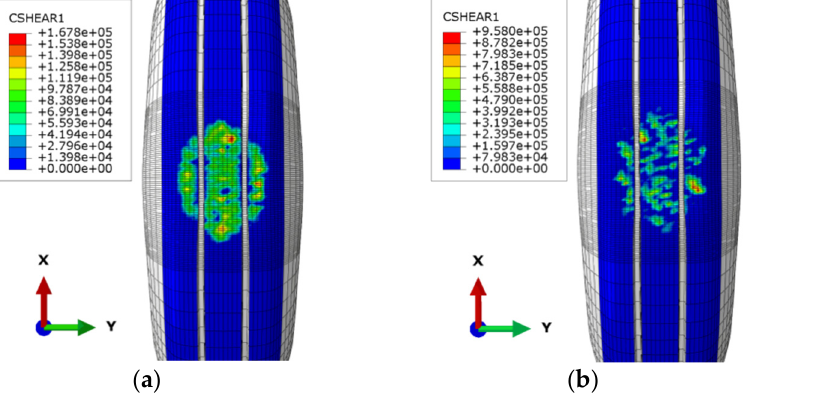
Figure 9. Cloud chart of shear force distribution on different pavements. ( a ) AC Pavement ( b ) SMA Pavement ( c ) OGFC Pavement.